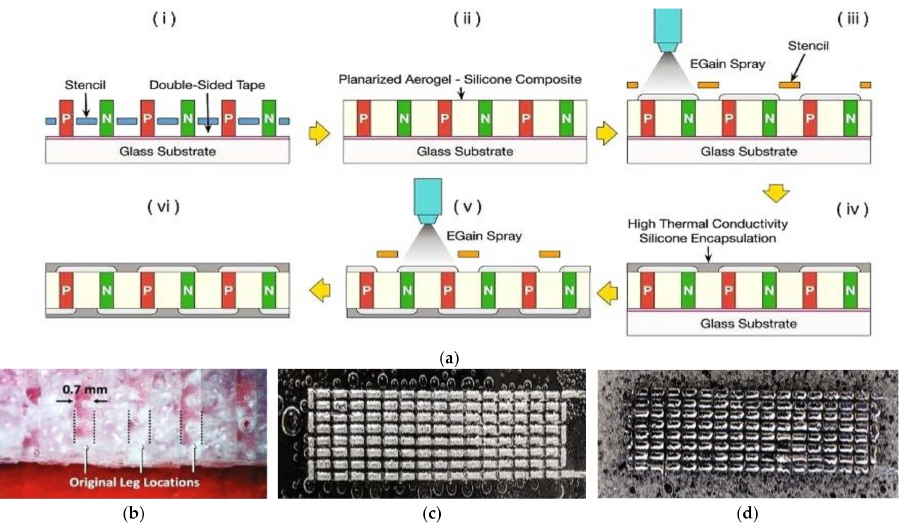
Figure 8. Flexible TEGs’ process of fabrication ( a ); The cross-section view at the microscope of a TEG after removing the legs ( b ); the surface of EGaIn interconnects on a module using pure PDMS ( c ) and aerogel-silicon filler ( d )